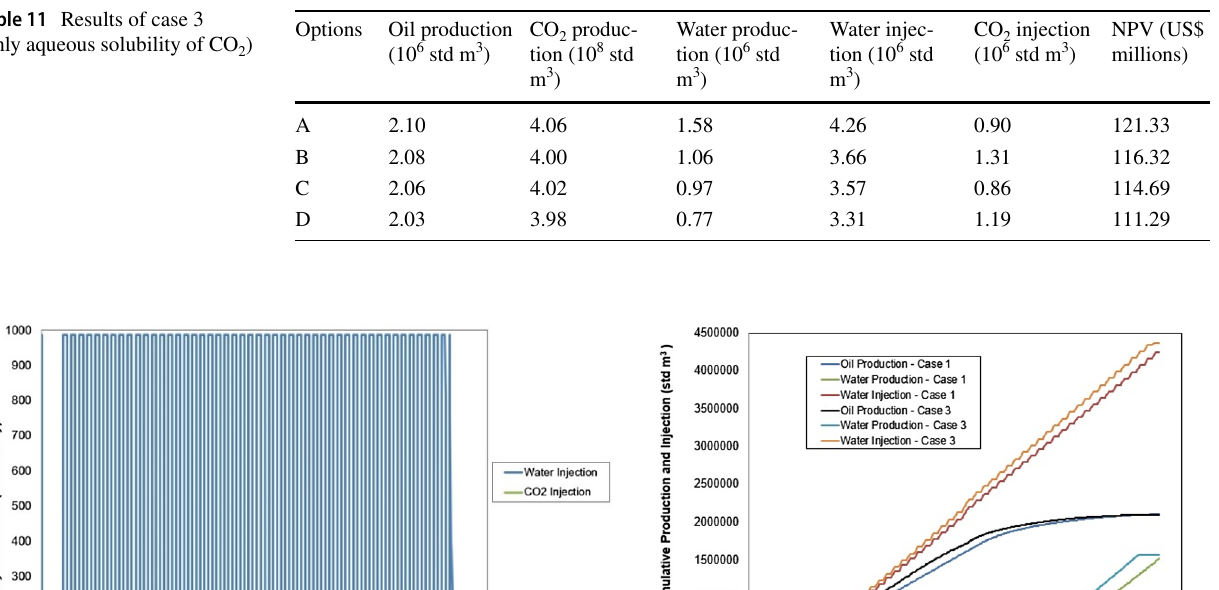
(only aqueous solubility of CO 2 )